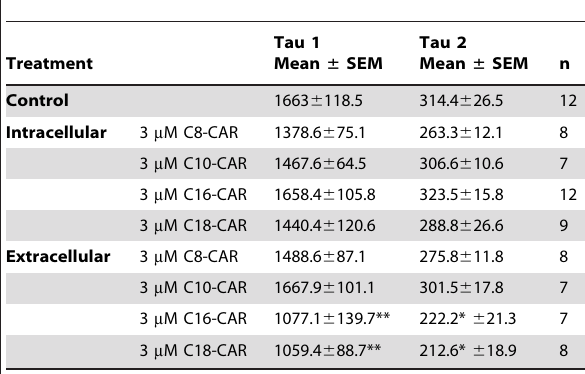
Table 1. Effect of application of intra- or extracellular acyl- CARs on I hERG deactivation time constants.The hERG